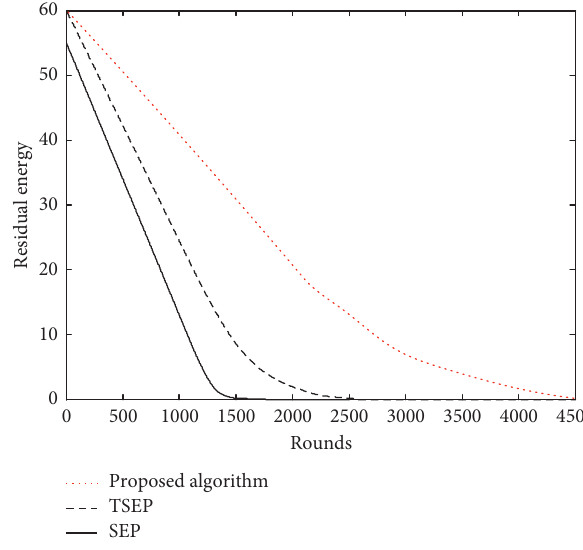
Figure 4: Residual energy with tree